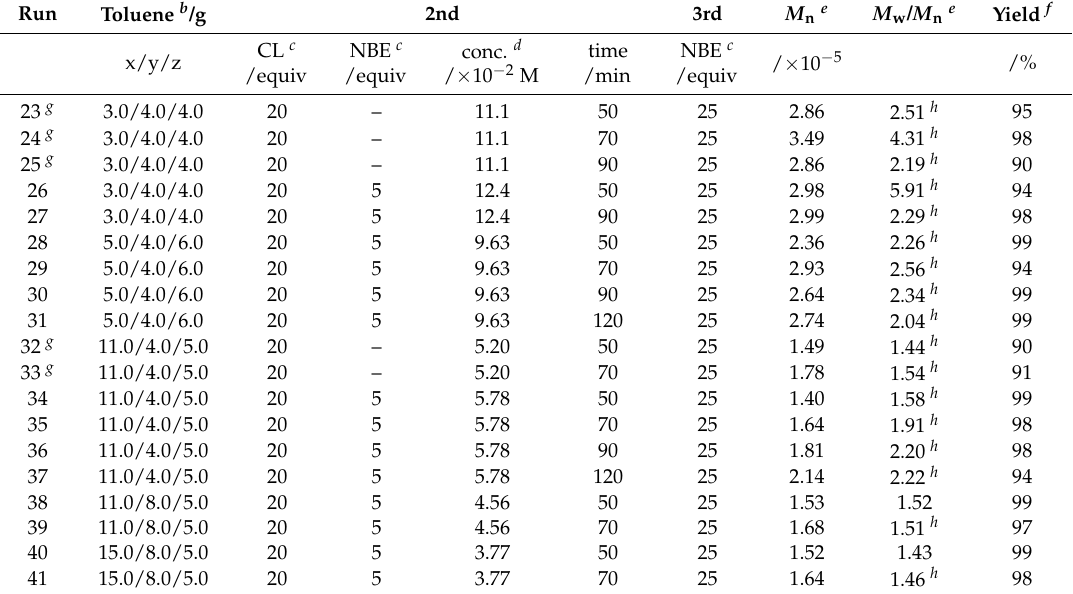
Table 2. Synthesis of star-shaped polymers by living ring-opening metathesis polymerization (ROMP) using Mo(CHCMe 2 Ph)(N-2,6- i Pr 2 C 6 H 3 )(O t Bu) 2 (Method 2) a .